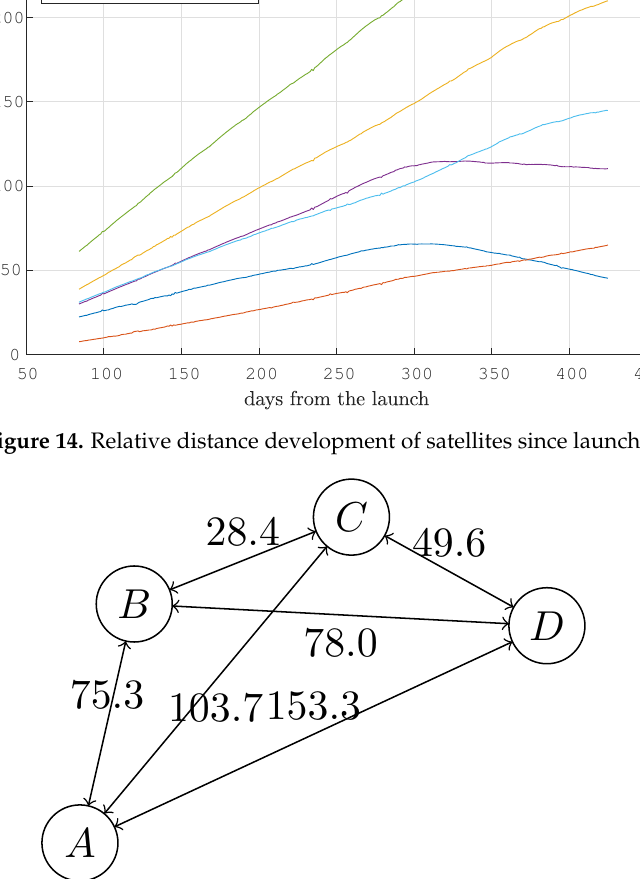
Figure 15. Graph representation of S-NET nodes (August 2018, not to scale) with numbers in